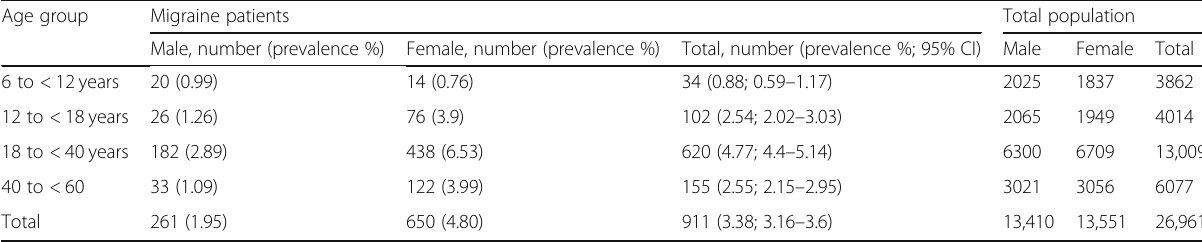
Table 1 Age and sex lifetime prevalence of migraine among the studied population Age group Migraine patients